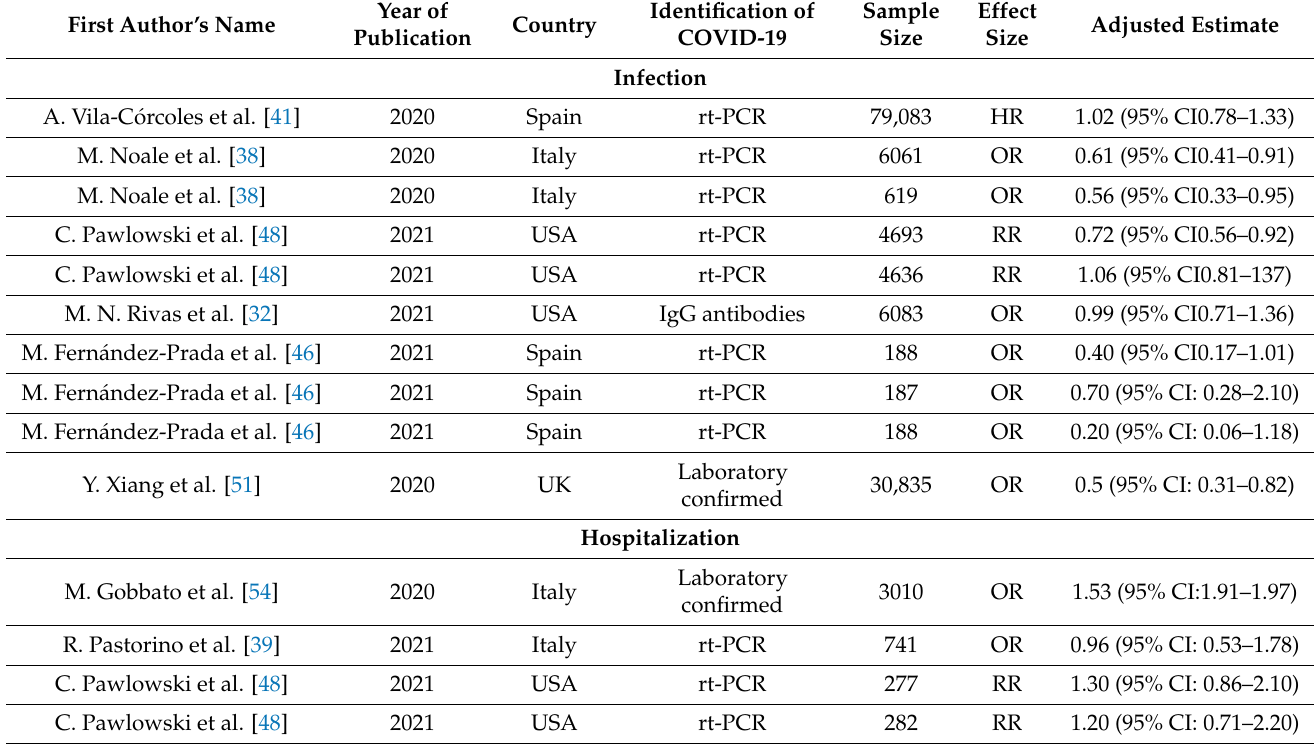
Table 3. Baseline characteristics of (a) six publications, involving 10 studies, that assessed the association between pneumococcal vaccination and SARS-CoV-2 infection, (b) four studies that assessed the association between pneumococcal vaccination and the risk of hospitalization, and (c) three studies that assessed the association between pneumococcal vaccination and the risk of requiring intensive